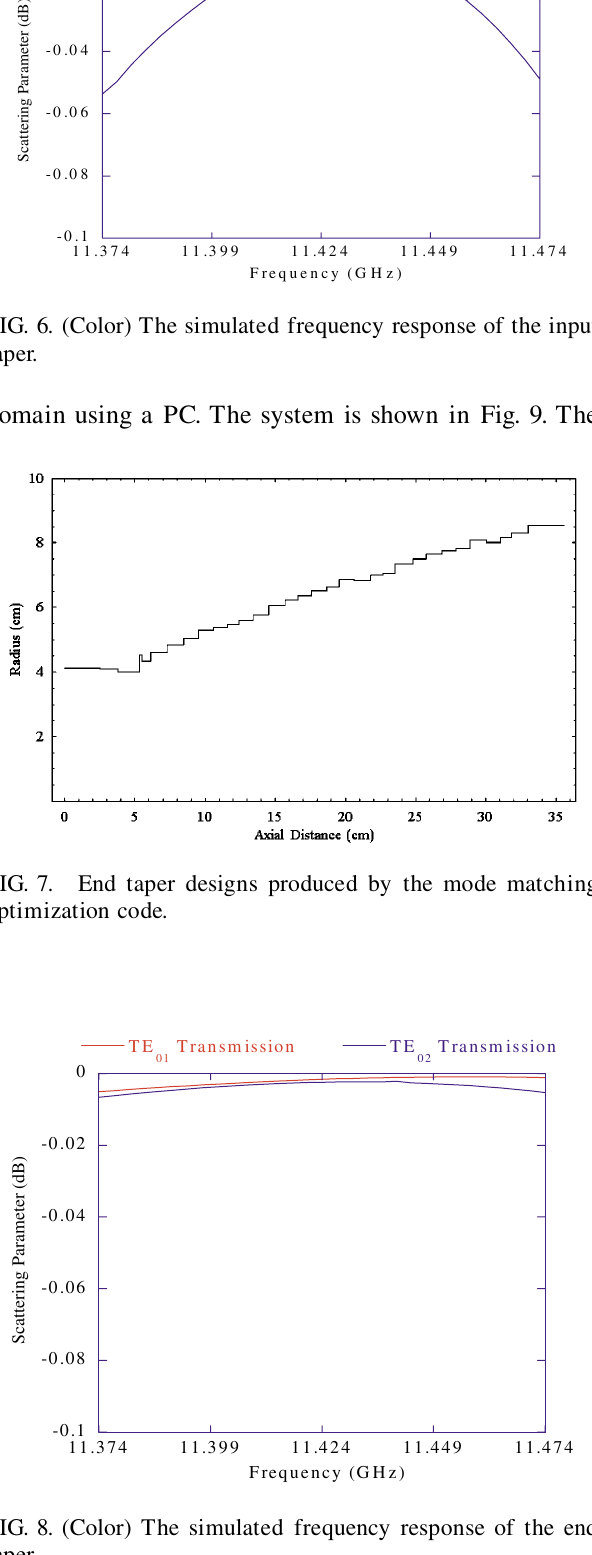
FIG. 8. (Color) The simulated frequency response of the end